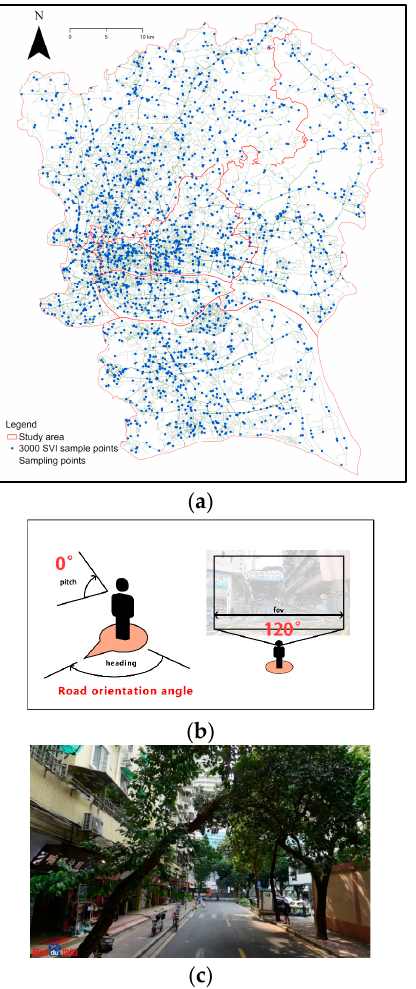
Figure 3. Download SVIs by Baidu Map API. ( a ) A randomly selected sample of SVIs, ( b ) SVI download parameters were set, and ( c ) a typical SVI.